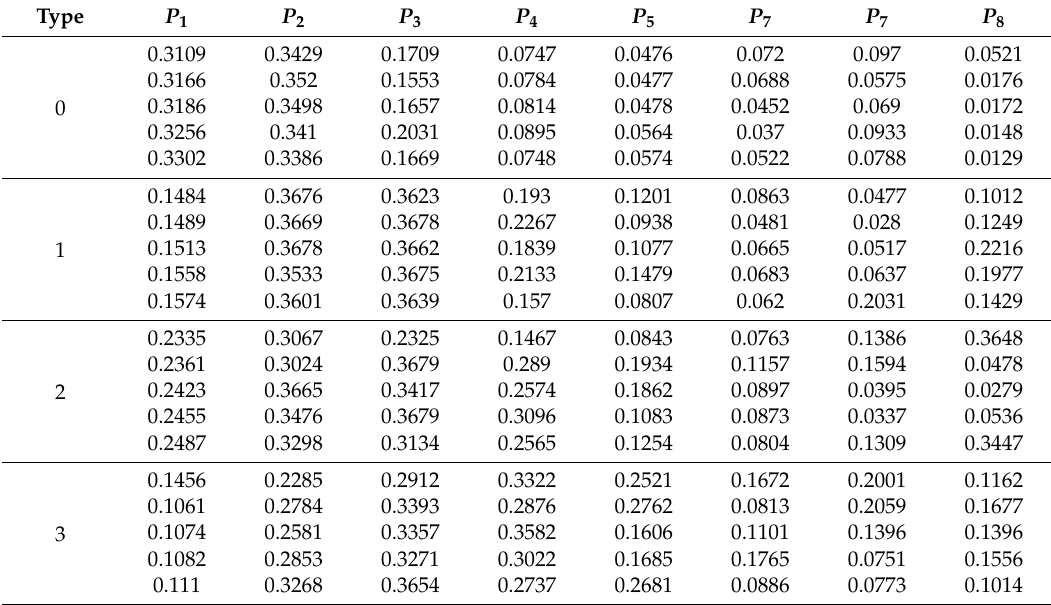
Table 4. The partial data of the energy entropy of the first eight IMF components of